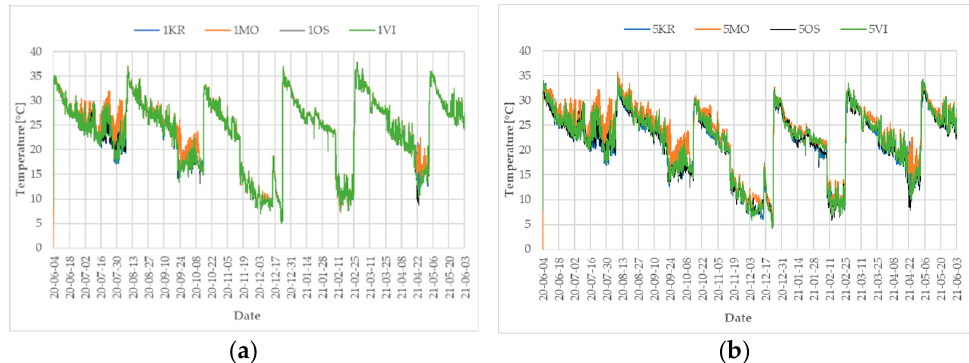
Figure 14. The course of floor temperature, depending on the location of the test site, at points: ( a )—measurement point 1; ( b )—measurement point 5.